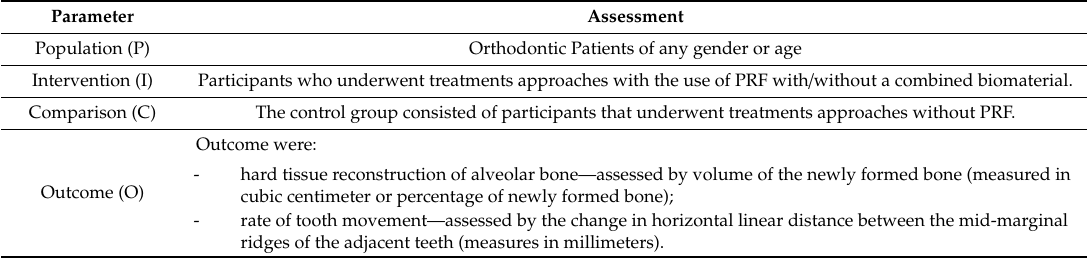
Table 1. Research question according to the PICO